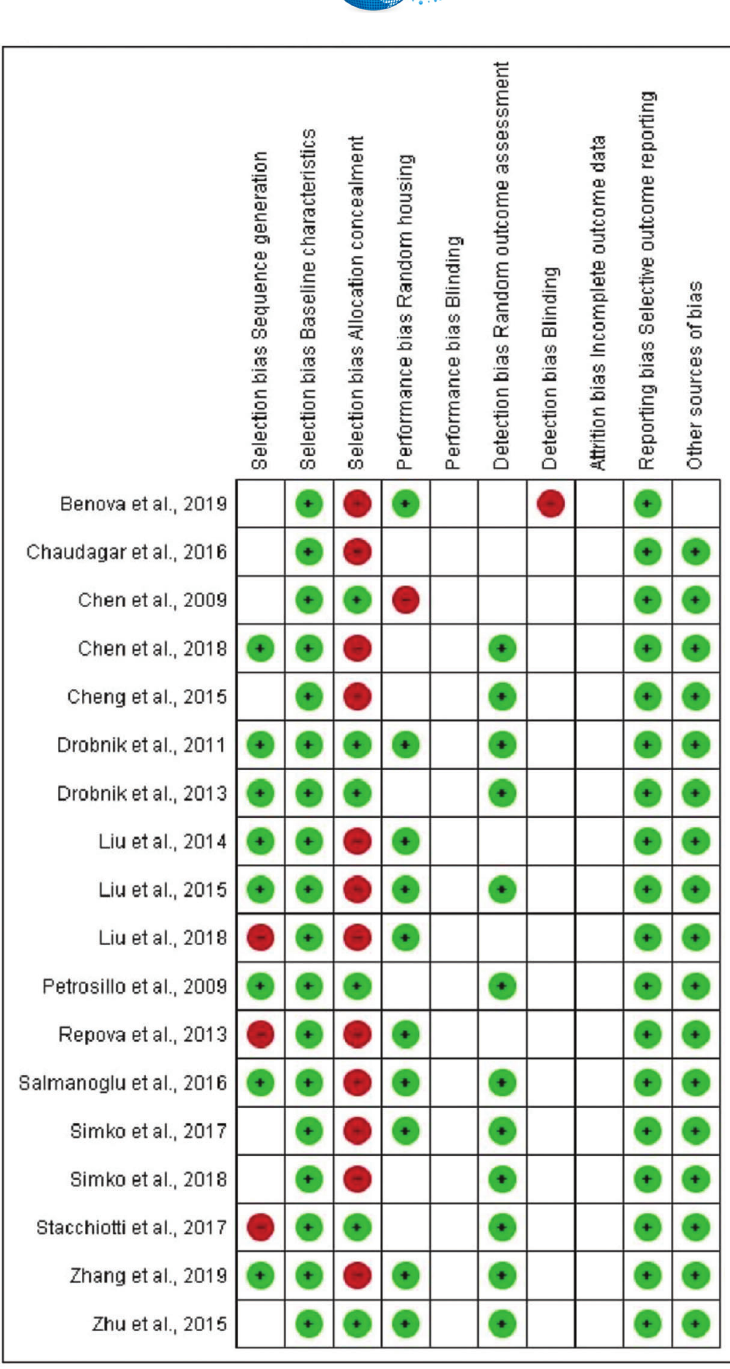
Figure 5 - Risk of bias summary: review of authors ’ judgment regarding each risk of bias item for each included